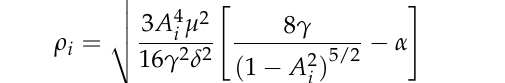
Figure 3. Frequency response curve for solutions).